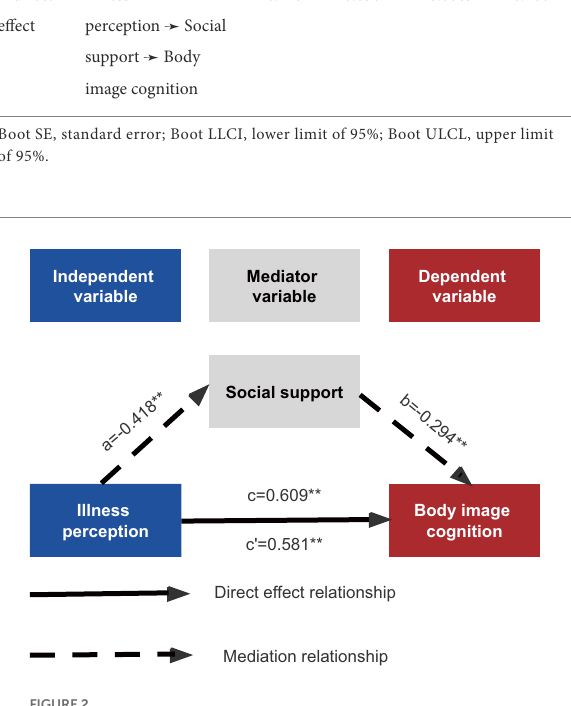
FIGURE 2 The diagram of the mediation effect of social support (** p <